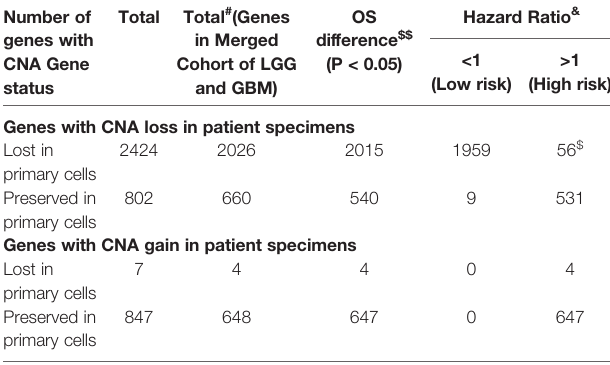
TABLE 5 | The top molecular and biological functions associated to CNA genes in TABLE 6 | The univariate Cox regression analysis of the association between grade II/III CNA-preserved, grade II/III CNA-lost, and GBM CNA-preserved group. overall survival of glioma patients and CNAs of targeted genes in the patient cohort from the Merged Cohort of LGG and GBM Category Involved Grade II/ Grade II/III GBM CNA- #Molecules IIICNA-lost CNA-pre- preserved served V Cellular Growth and